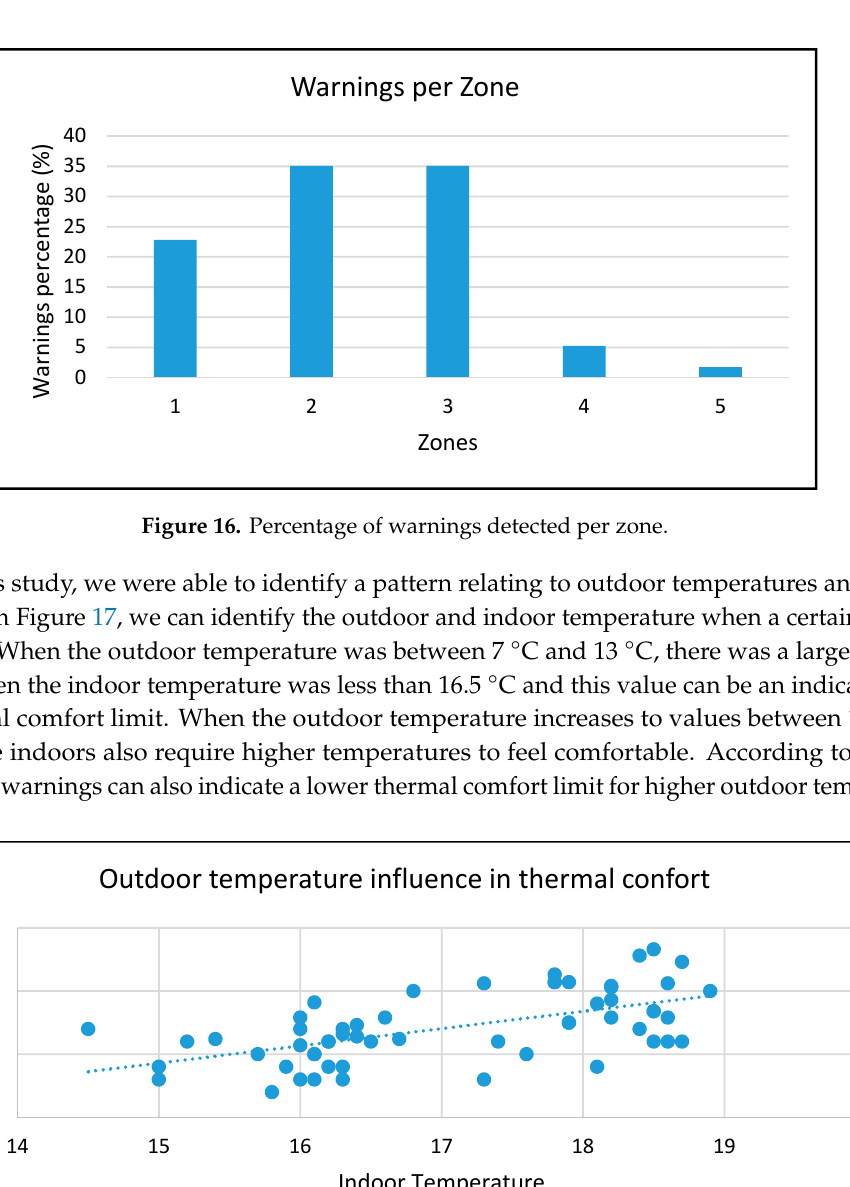
temperature when the warning was created.